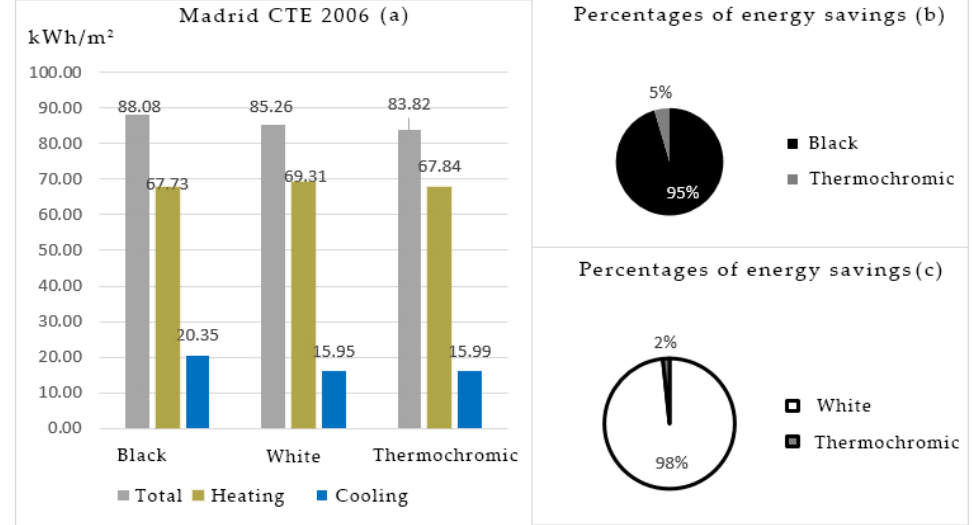
Figure 14. ( a ) Energy demand for heating and cooling in the case of Madrid CTE 2006. ( b ) Thermochromic vs. black surface finish energy savings. ( c ) Thermochromic vs. white surface finish energy savings.